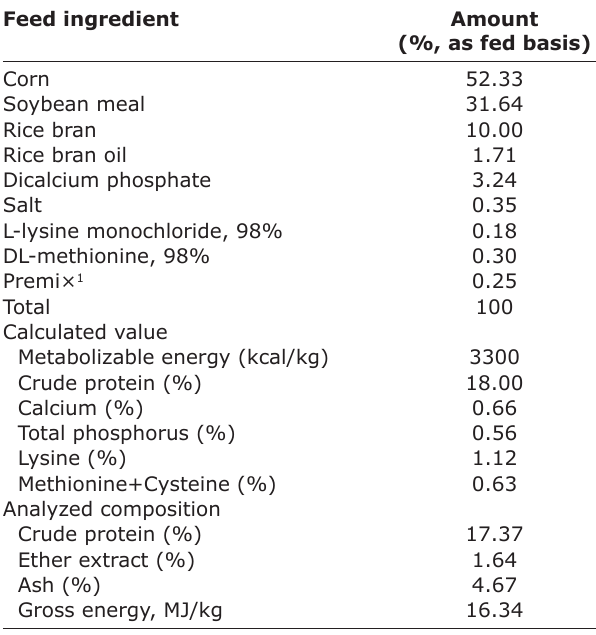
Table-2: Feed ingredient and nutrient composition of the basal